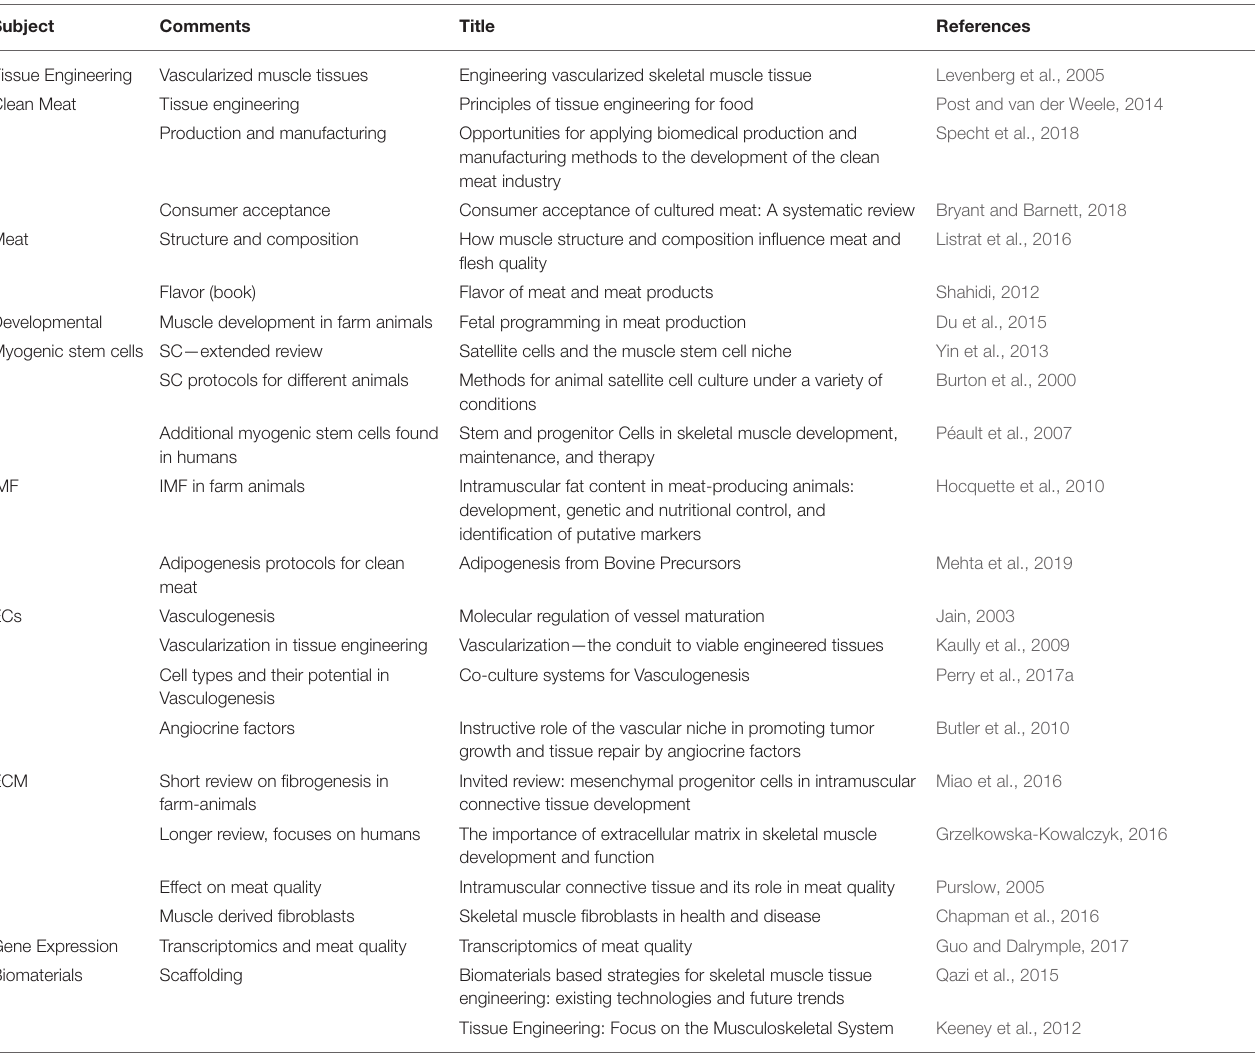
TABLE 1 | Additional reading